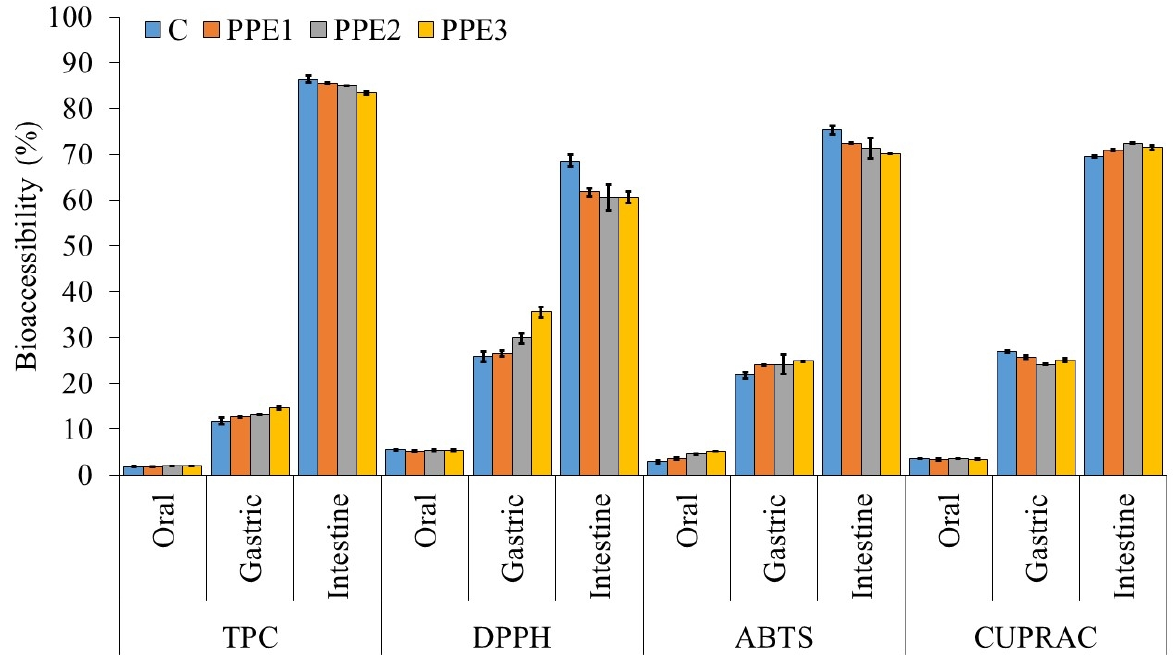
Figure 6. The in vitro bio-accessibility of “Boba balls” containing pomegranate peel extract (PPE) at various concentrations. (C: Control without PPE; PPE1: “Boba balls” containing 1% PPE; PPE2: “Boba balls” containing 2% PPE; PPE3: “Boba balls” containing 3% PPE).